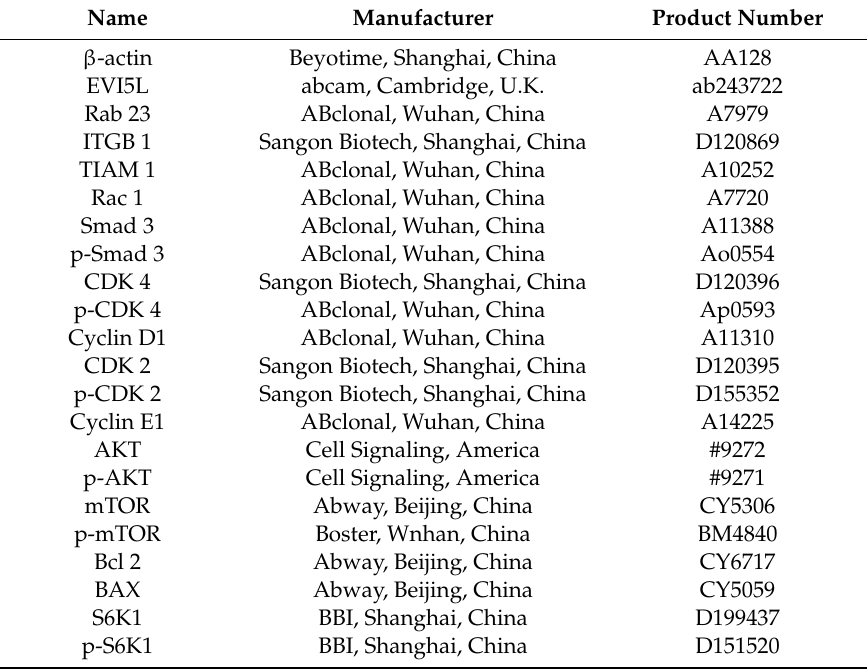
Table 2. All of the main antibodies of Western blot